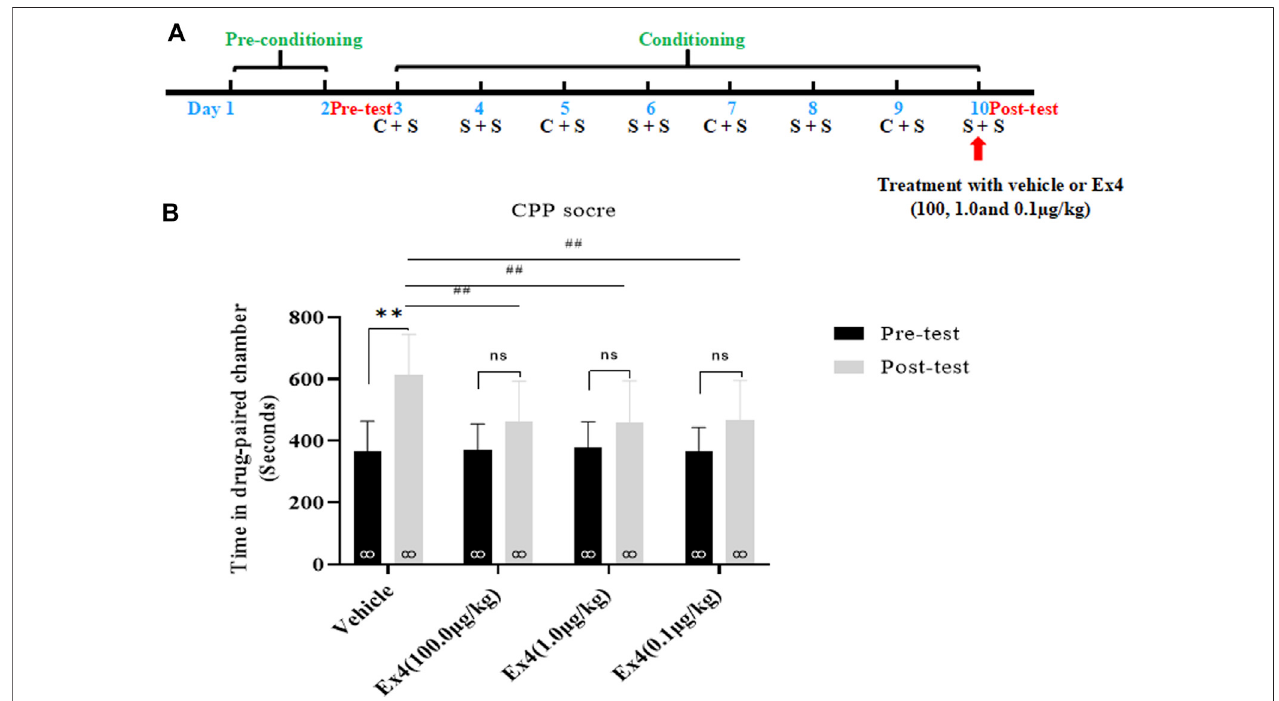
FIGURE 2 | Ex4 ’ s single treatment blocks expression of cocaine-induced CPP. (A) The experimental schedule for saline (S) as well as cocaine (C) and Ex4 treatments. (B) CPP scores following a single treatment withvehicle and Ex4 (100, 1.0, and 0.1 μ g/kg) on the CPP test day show that cocaine induced a signi fi cant CPP that was blocked by systemic Ex4 treatment. ** represents p < 0.01 vs pretest, ns represents no signi fi cant difference, paired t-test. ## represents p < 0.01 vs vehicle, one-way ANOVA followed by a Dunnett ’ s post hoc test. All data are presented as the mean ± SEM.